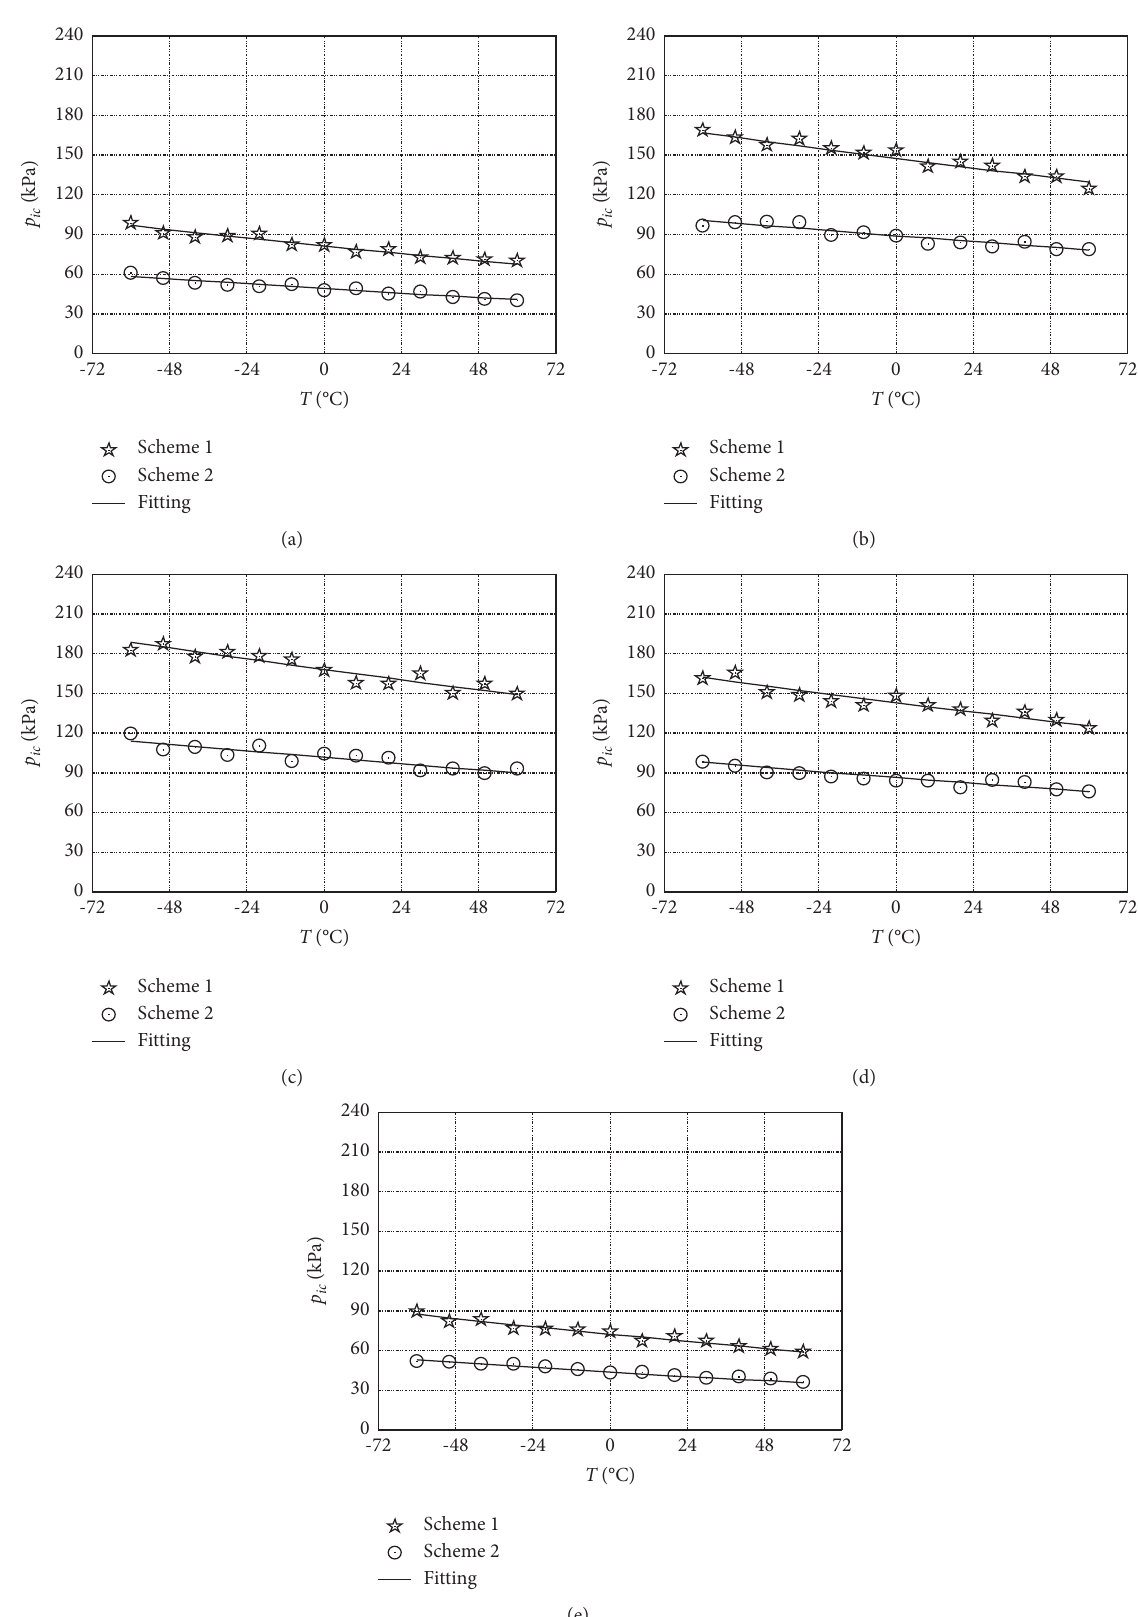
Figure 6: Relation between (p) ic and (T) under different initial gas volume concentration environments. (a) (C) (c) (C) � 10% (d) (C) � 12%. (e) (C) �